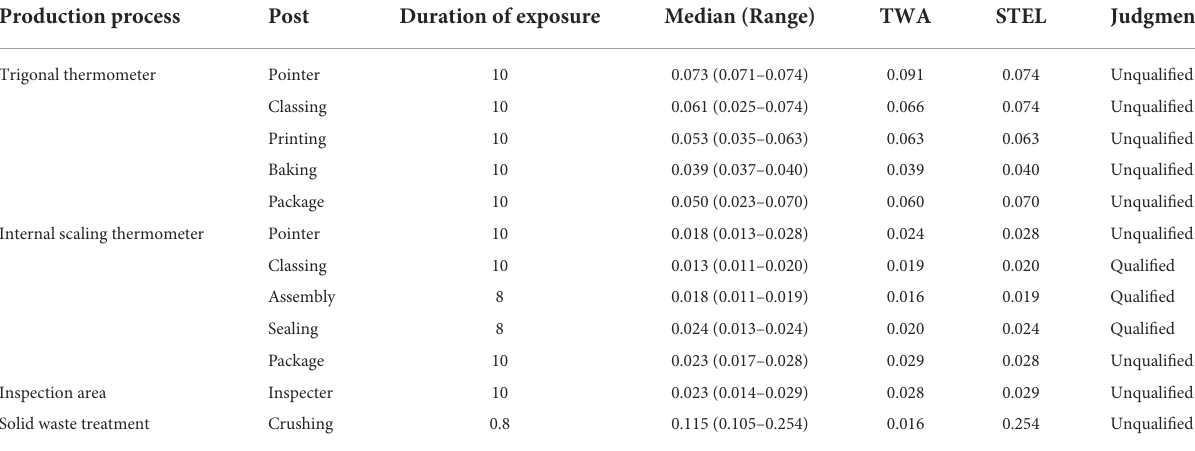
TABLE 1 Results of mercury concentration tests in 2019 (mg/m 3 ).